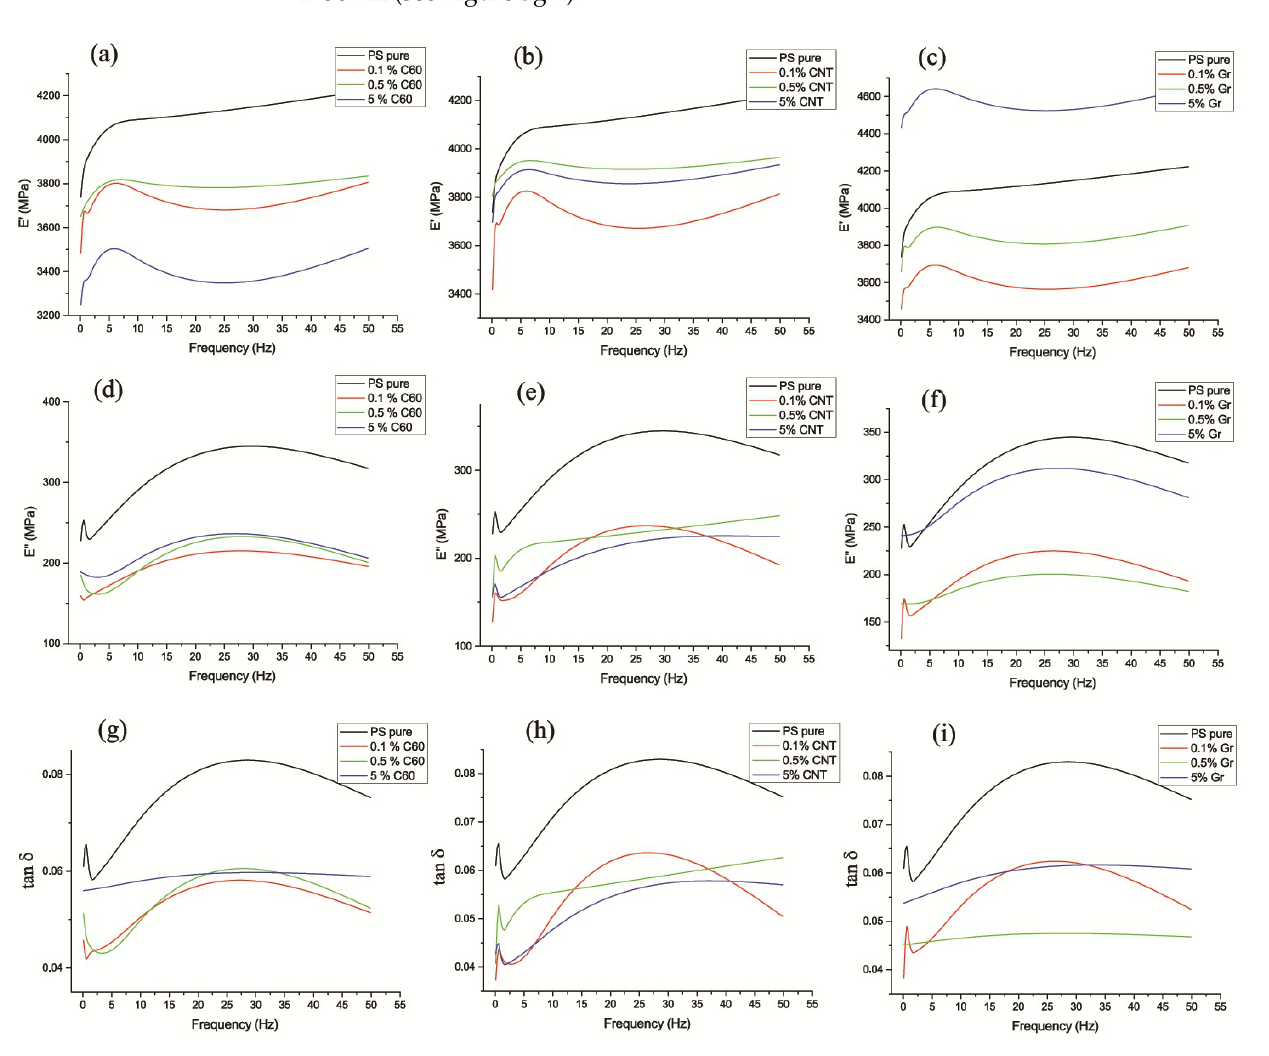
Figure 5. Frequency dependencies of the elastic modulus E (cid:48) ( a – c ), loss modulus E (cid:48)(cid:48) ( d – f ) and mechanical loss tangent tan δ ( g – i ) of PS-based composites filled with fullerenes C60 ( a , d , g ), carbon nanotubes CNT ( b , e , h ) and graphene Gr ( c , f , i ), obtained by